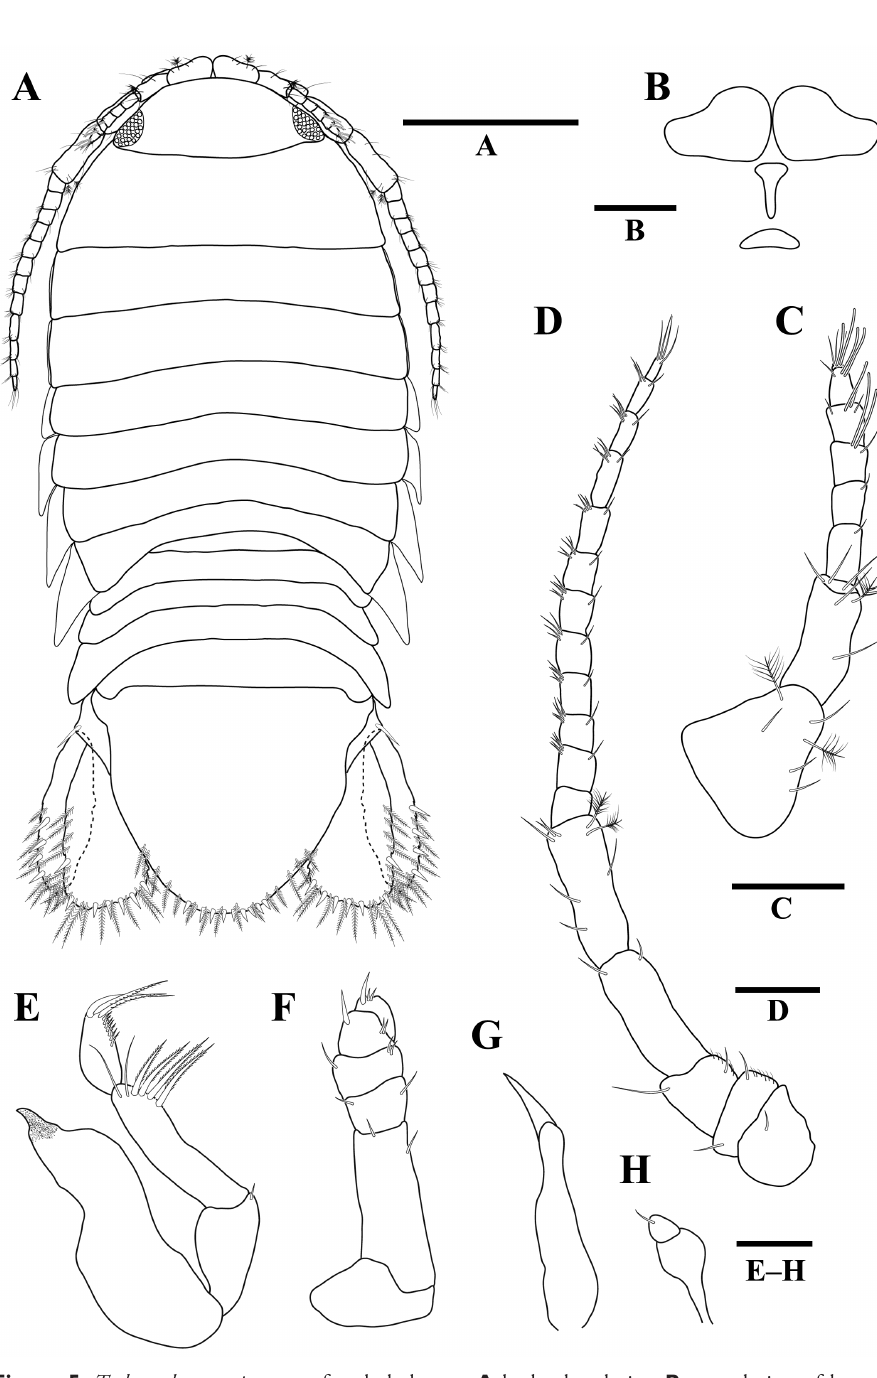
Figure 5. Tachaea koreaensis sp. n., female holotype. A body, dorsal view B ventral view of bases of antennula, frontal lamina, and clypeus C antennula D antenna E mandible F maxilliped G maxillula H maxilla. Scale bars: 1 mm ( A ), 0.5 mm ( B ), 0.2 mm ( C, D ), 0.1 mm ( E–H